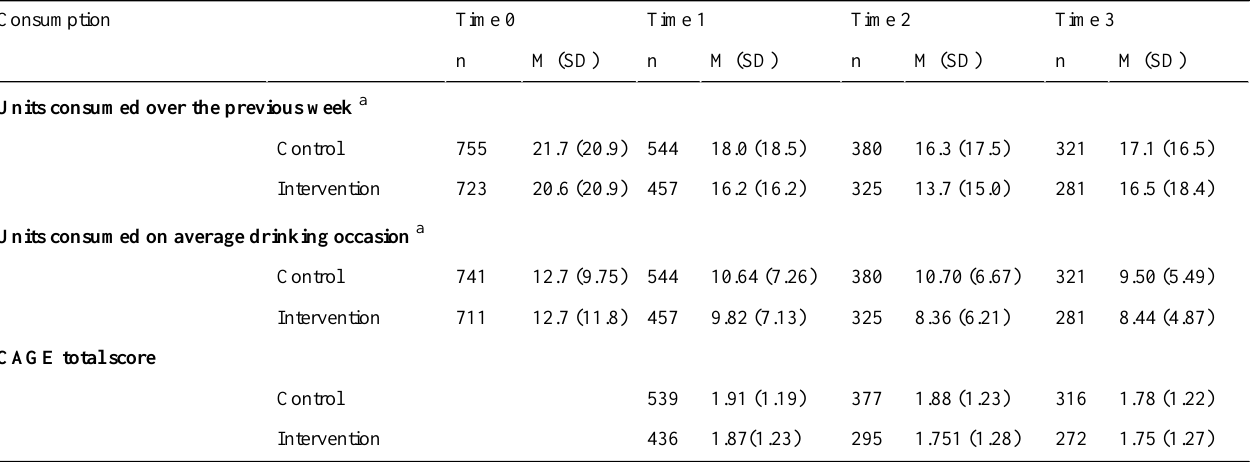
Table 2. Units per occasion, per previous week, and CAGE total score by treatment